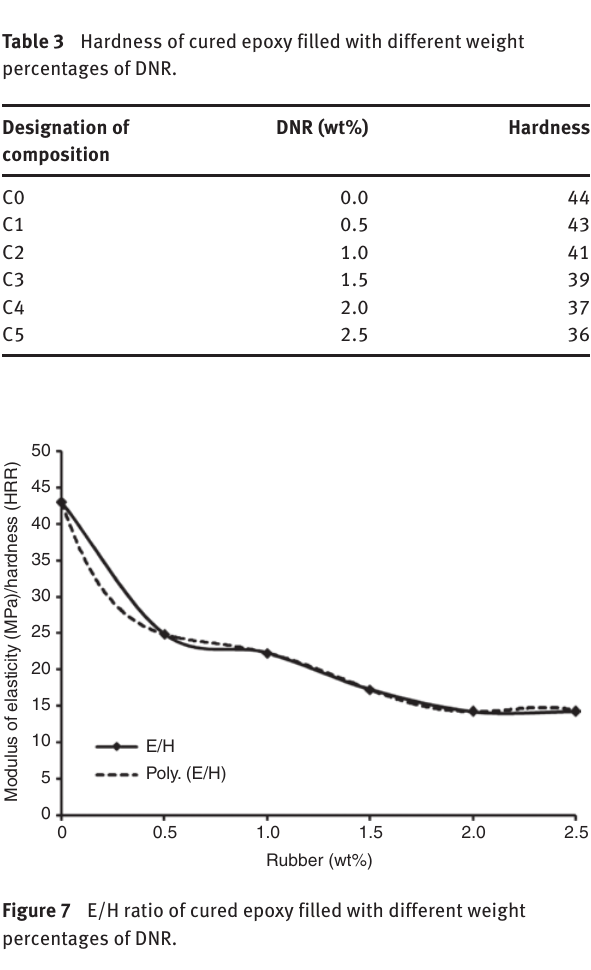
percentage of DNR. Equation (3) indicates that the non- linear relationship between the modulus of